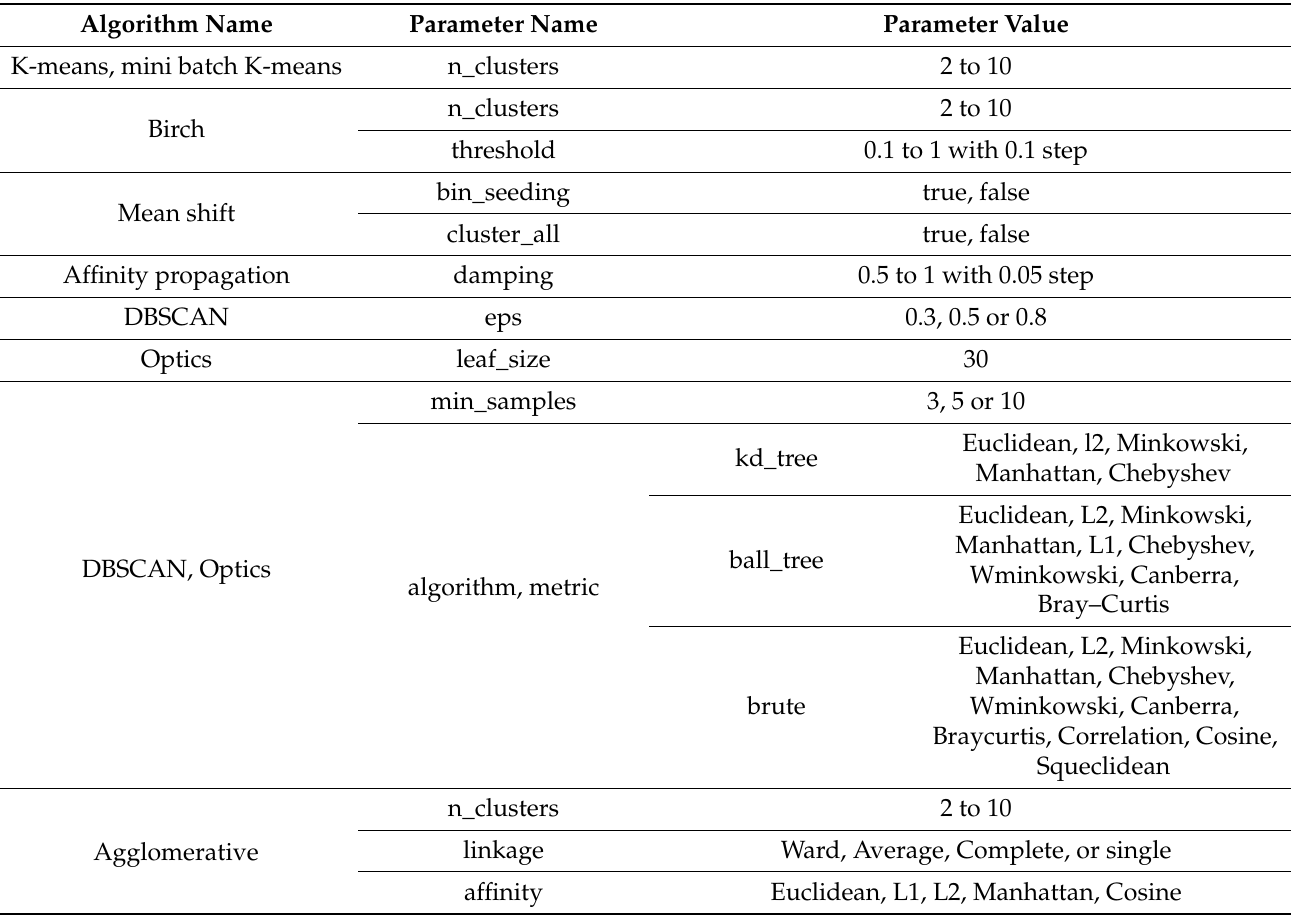
Table A3. Clustering algorithm